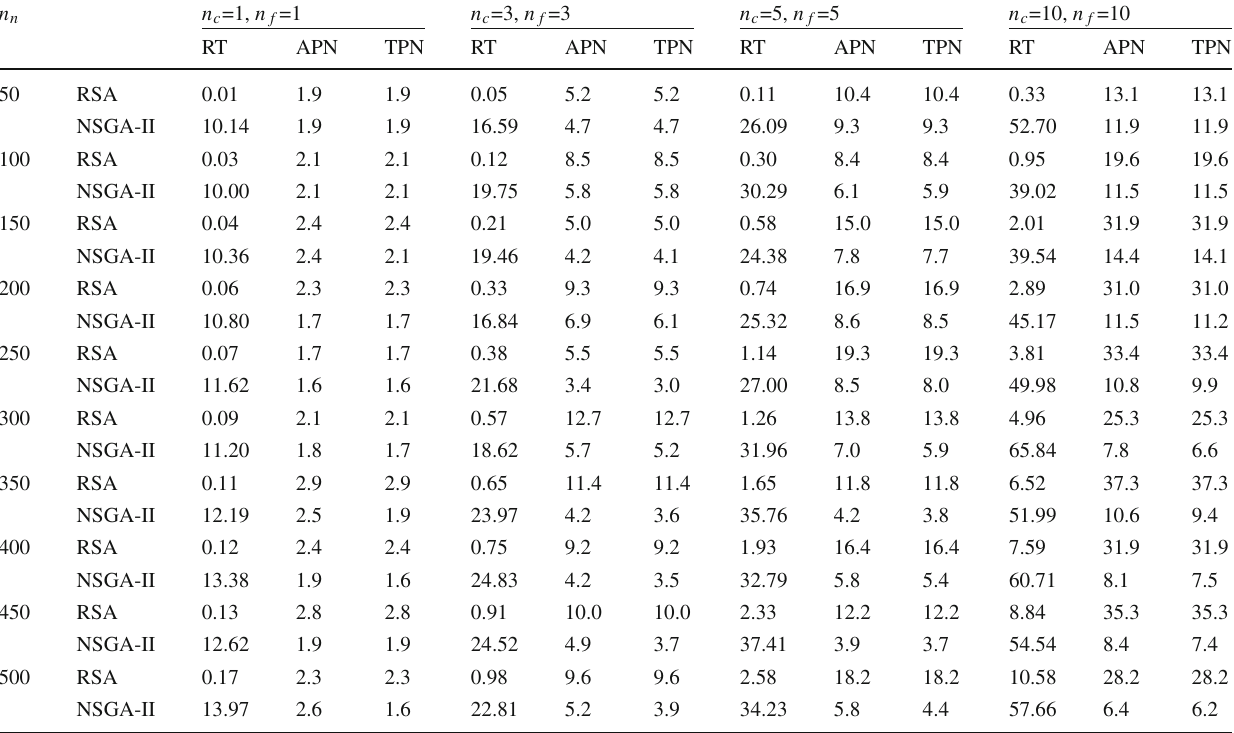
Table 7 The results of the comparative experiments of the RSA and NSGA-II n